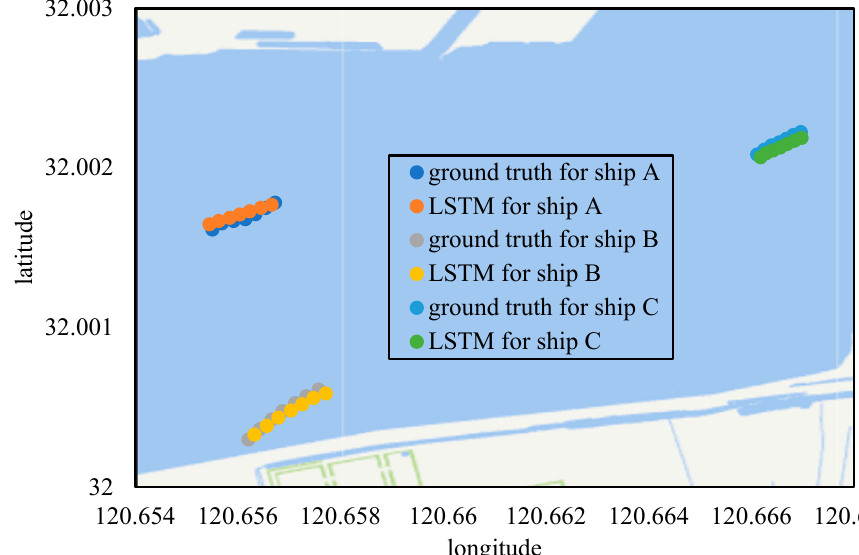
Figure 4. LSTM model prediction performance for different ships.